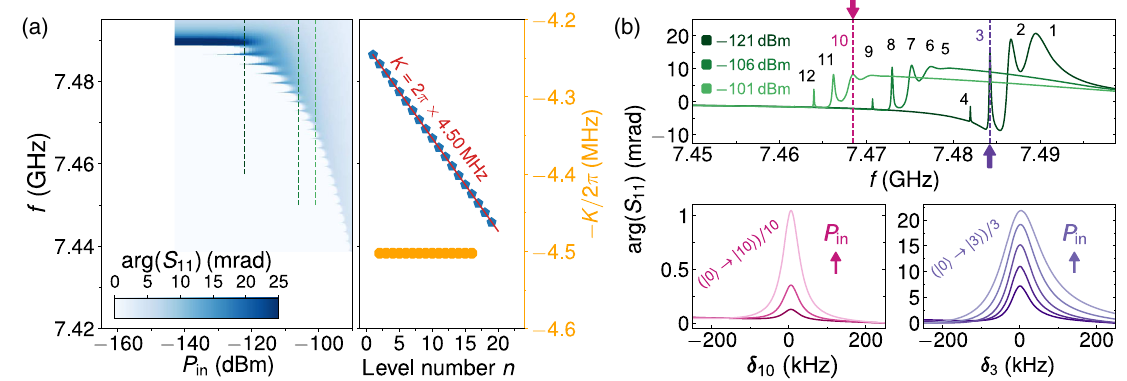
FIG. 10. Numerical calculation of the energy spectrum. (a) Phase of the numerically calculated reflection coefficient arg ð S 11 Þ as a function of probe frequency f and probe power P (left-hand panel) according to Appendix D. The multiphoton peaks are equally in spaced in frequency, with the difference given by K= 2 ¼ 2 π × 2 . 25 MHz (right-hand panel). In contrast to the experiment, we observe a constant frequency shift K (orange markers, right-hand panel), as expected, because the Kerr Hamiltonian in Eq. (D1) only contains − 121 , − 106 , and terms up to the fourth order. (b) Three individual traces (top panel) calculated at distinct drive powers ( P probe ¼ − 101 dBm). Similarly to the experimental results shown in Fig. 3(b), several multiphoton transitions are visible at any given drive power in this range. With increasing power, the linewidth of the transitions broadens as depicted by the enlargements (bottom panels) around − 127 to − 123 dBm) and tenth (left, P − 105 . 75 to − 104 . 75 dBm) multiphoton the third (right, P probe ¼ probe ¼